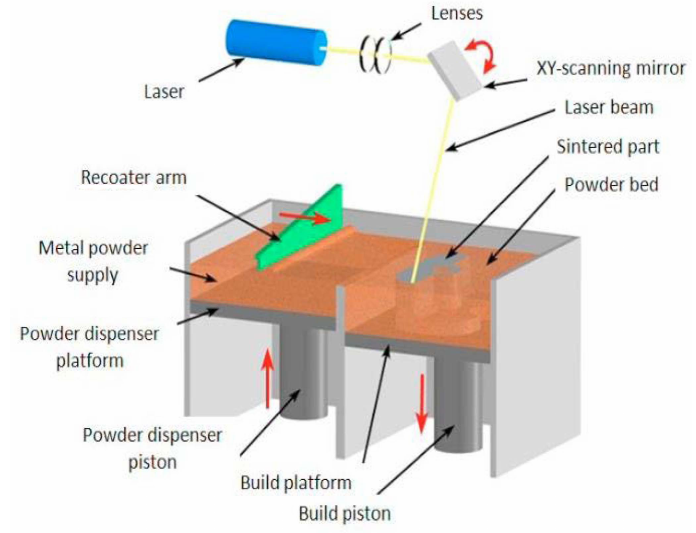
Figure1. Theselectivelasersinteringprocess, reproducedfrom[28],